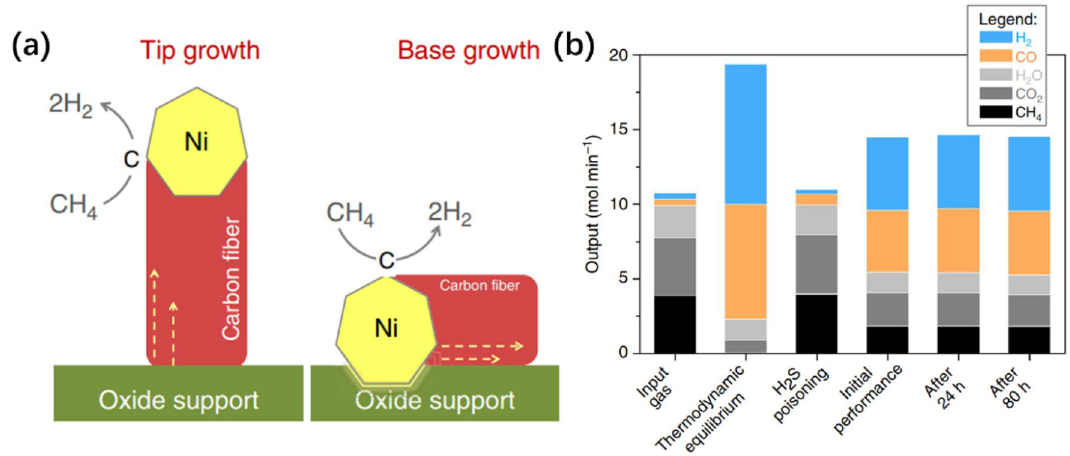
Fig. 5 a Schematic of possible carbon fiber growth mechanism, b reforming test on a La Ni particles. Reproduced with permission [53]. Copyright 2015, Springer